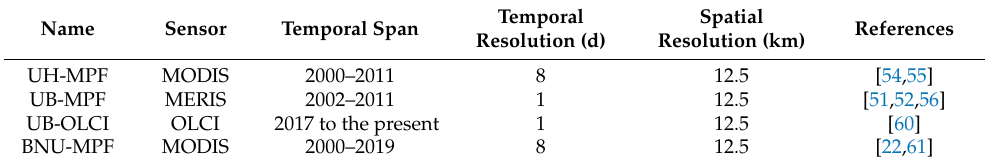
Table 1. MPF datasets for Arctic sea ice derived from satellite